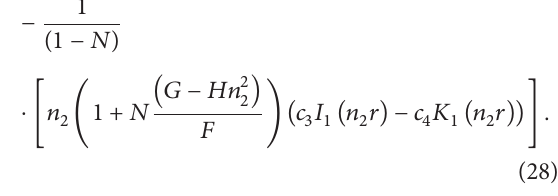
0.1 , 𝑁 = 0.75 , 𝑚 = 50 , 𝑢 = 0.01 , and 𝜙 = −0.05 .